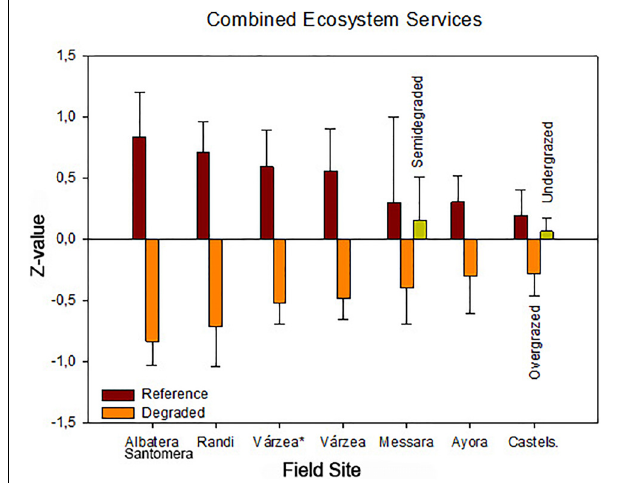
FIGURE 5 | Summary of the loss of standardized ecosystem services (water and soil conservation, nutrient cycling, C sequestration, and fire risk reduction, the latter only in Ayora) and biodiversity due to the local degradation stress in all field sites. Bars represent an average of all five ecosystem services evaluated. Várzea* refers to the C sequestration service including estimated biomass of the overstory with bibliographic